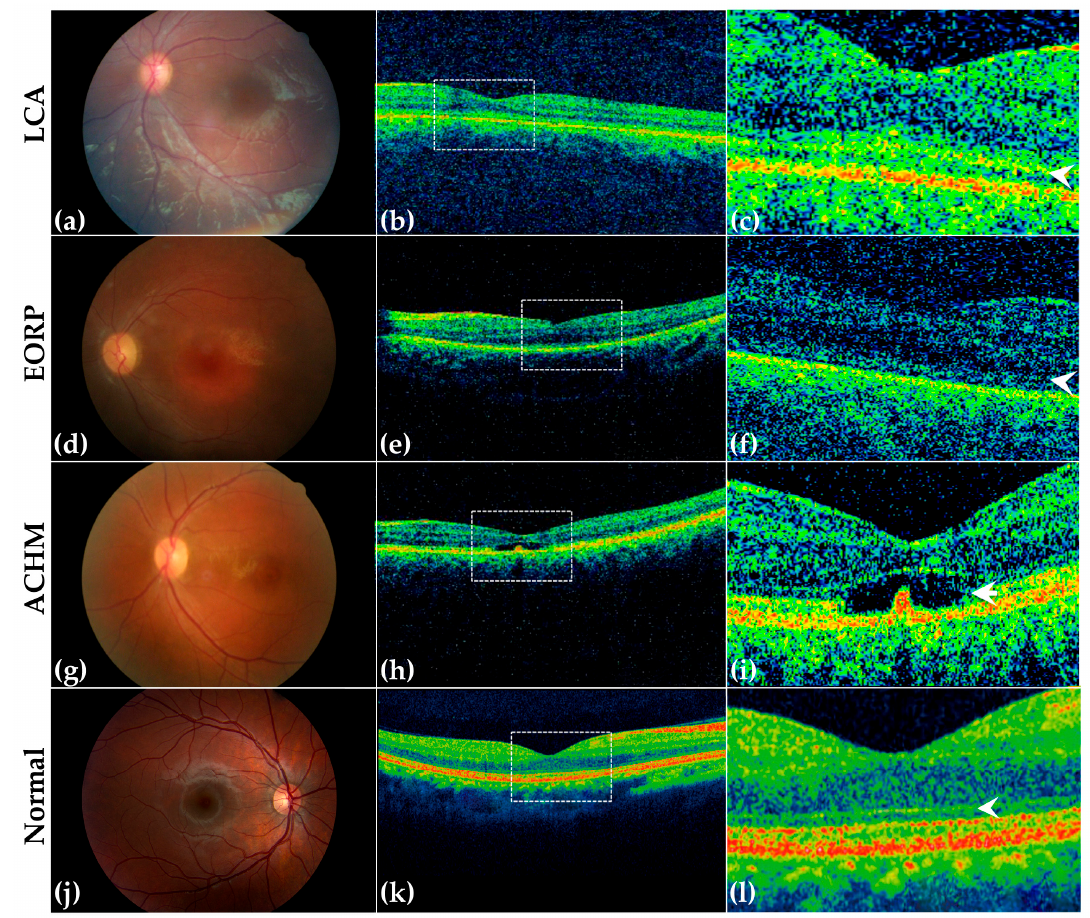
Figure 2. Ophthalmological findings in three representative patients with LCA, EORP, ACHM, and in a normal young proband. Retinography ( a , d , g , j ) and optical coherence tomography (OCT) images ( b , e , h , k ) of representative LCA (pt. 10, mutations in CNGB3 , a – c ), EORP (pt. 31, mutations in CEP290 , d – f ) and ACHM (pt. 8, mutations in CNGB3 , g – i ) patients, and of a normal young proband ( j – l ). The retinography and OCT image of a normal retina is also shown ( j , k ). Insets ( c , f , i , l ) show a magnified view of the boxed areas in b, e, h and k, respectively. ( a – c ) Retinography of the LCA patient shows normal fundus appearance and OCT image demonstrates irregular EZ band (arrowhead in c ); ( d – f ) Fundus image from the EORP patient shows attenuation of the retinal vessels and “salt and pepper” retinal dystrophy. OCT shows absence of the EZ band (arrowhead in f ) and mild retinal pigment epithelium dystrophy; ( g – i ) Retinography and OCT of the ACHM patient reveals pigment mottling and disruption of the EZ band (arrowhead in i ), respectively. ( j – l ) Retinography of a normal young proband and corresponding OCT images. The arrowhead indicates the EZ band ( l ).